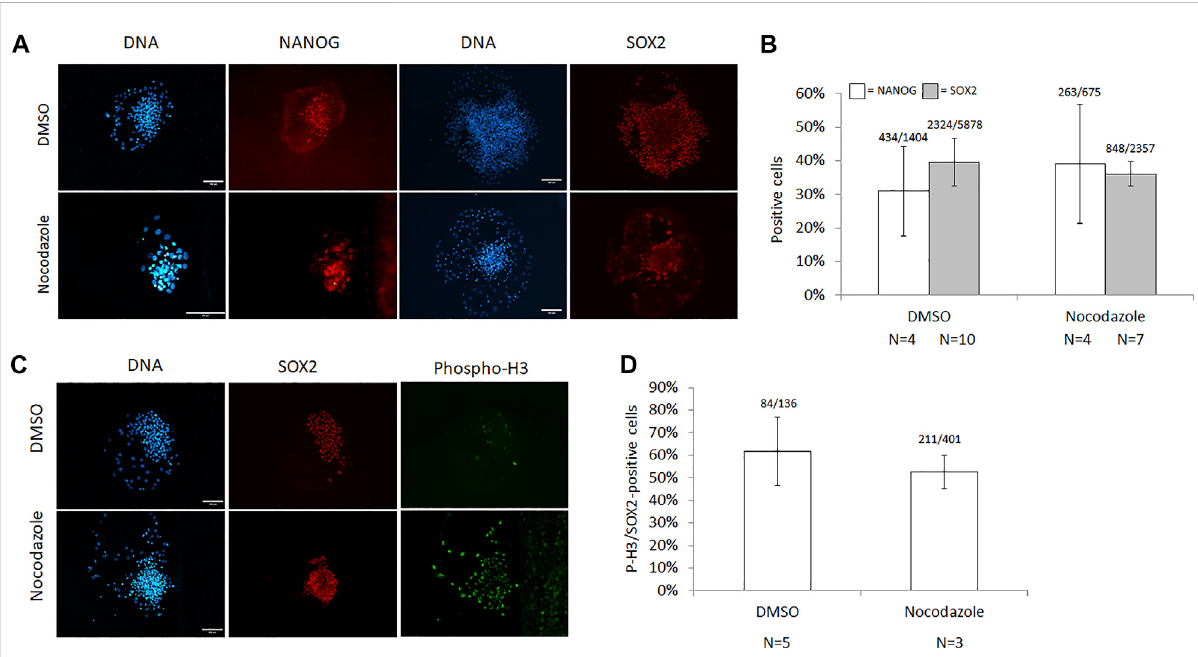
FIGURE 3 Characterization of pluripotency markers in nocodazole-synchronized ICM cells. (A) Images and (B) quanti fi cation of cells expressing NANOG and SOX2 following synchronization with nocodazole for 18 – 22 h. The number of Hoechst-stained nuclei (DNA) for NANOG (white bars) and SOX2 (grey bars) quanti fi cation was 2,079 ( p = 0.63) and 8,235 ( p = 0.26), respectively. (C) Images and (D) quanti fi cation of cells co-expressing P-H3 and SOX2followingsynchronizationwithnocodazolefor 18 – 22 h,and537P-H3-stainednucleiwerecounted ( p =0.45).Scalebar=100 μ m,error bars = SEM, N = colonies counted per treatment, and p -values from two-tailed t -test compared with